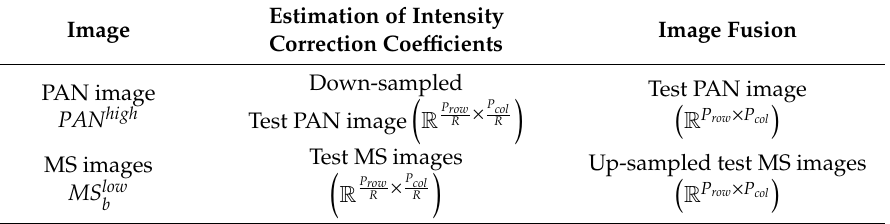
Table 2. Image size for the estimation of the intensity correction coe ffi cients and image